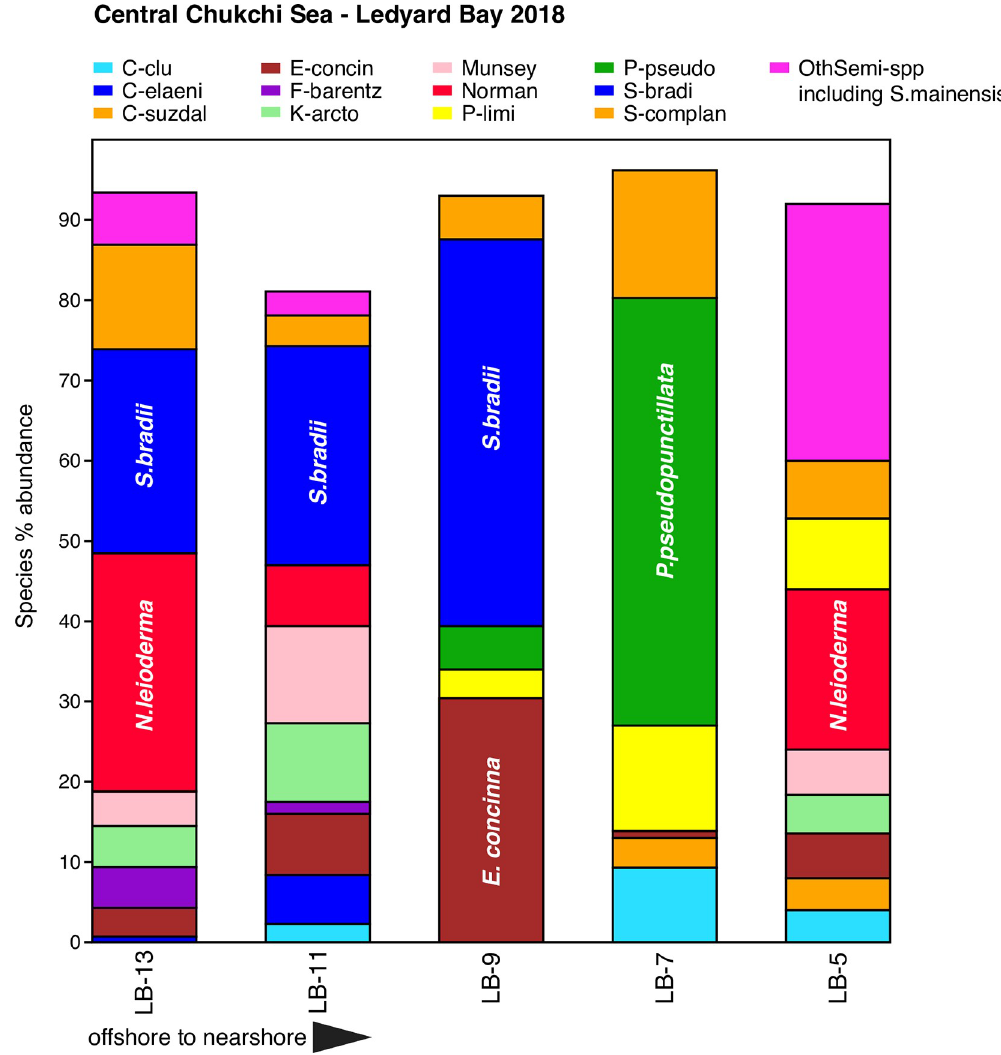
Fig 9. Primary species, Central Chukchi Sea–Ledyard Bay. Stack plot of the 12 most abundant species and one genus ( Semicytherura ), comprising > 90% of the ostracode assemblage at the 2018 Ledyard Bay transect (sites on Fig 2 map), southeast Chukchi Sea, (n = 5 surface sediment samples, all with � 50 specimens/sample, 558 total specimens).